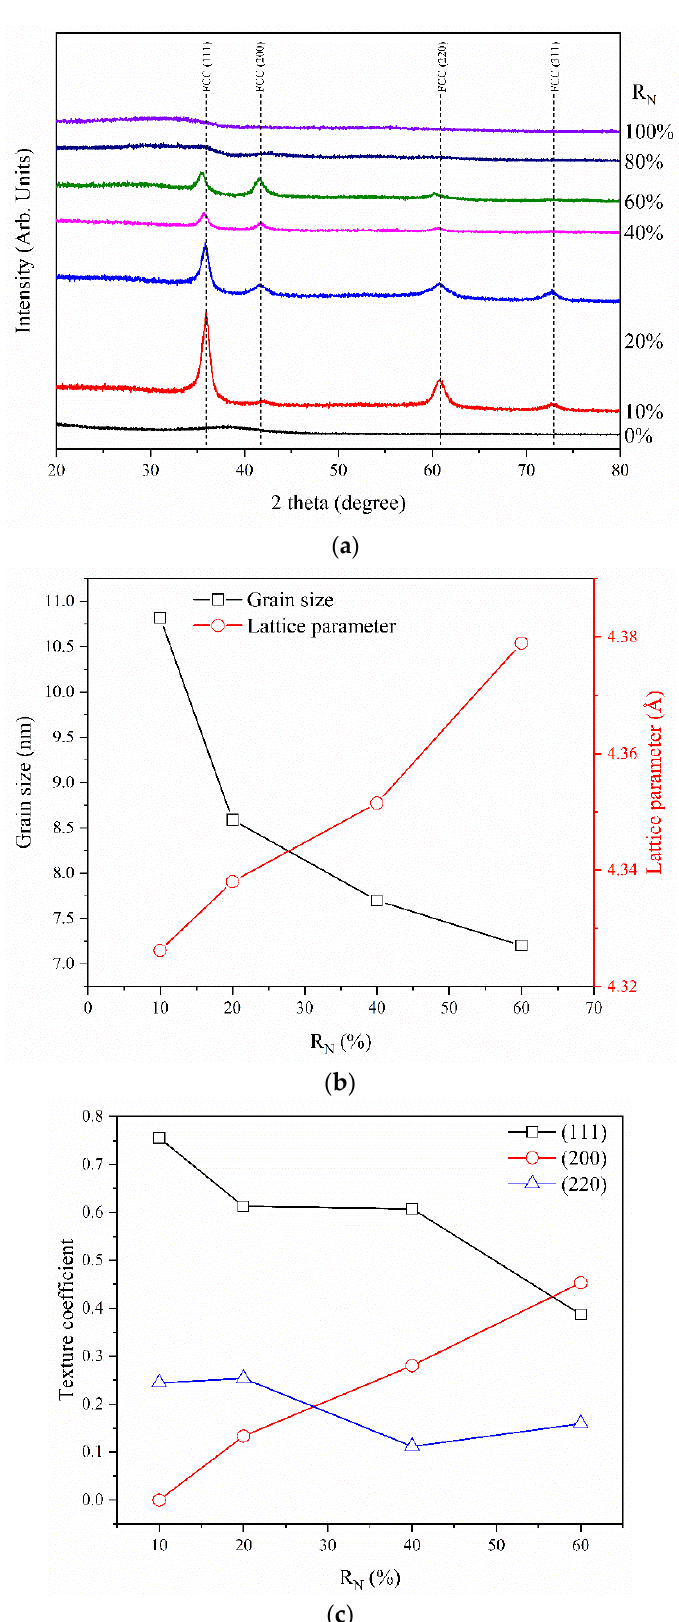
Figure 3. ( a ) X-ray diffraction patterns of (CrHfNbTaTiVZr)N coatings deposited at various R N . ( b ) Grain and lattice parameter of (CrHfNbTaTiVZr)N coatings deposited at various R N . ( c ) Texture coefficient of (CrHfNbTaTiVZr)N coatings deposited at various R N .